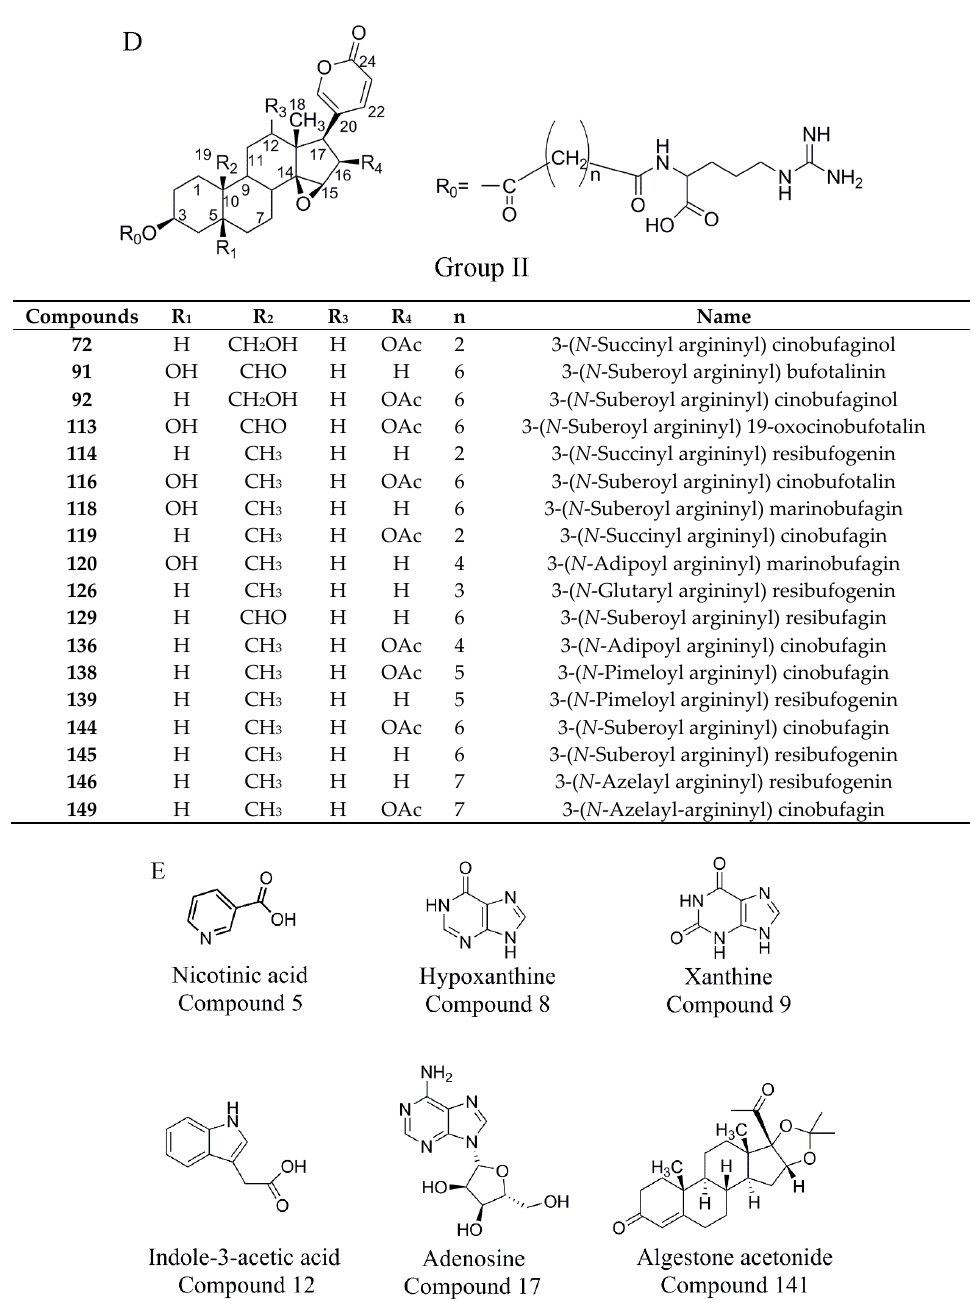
(C 14 H 27 O 5 N 4 ). Its fragment ion at m / z 296.1593, 278.1485, 272.1481, 250.1532, 175.1179,